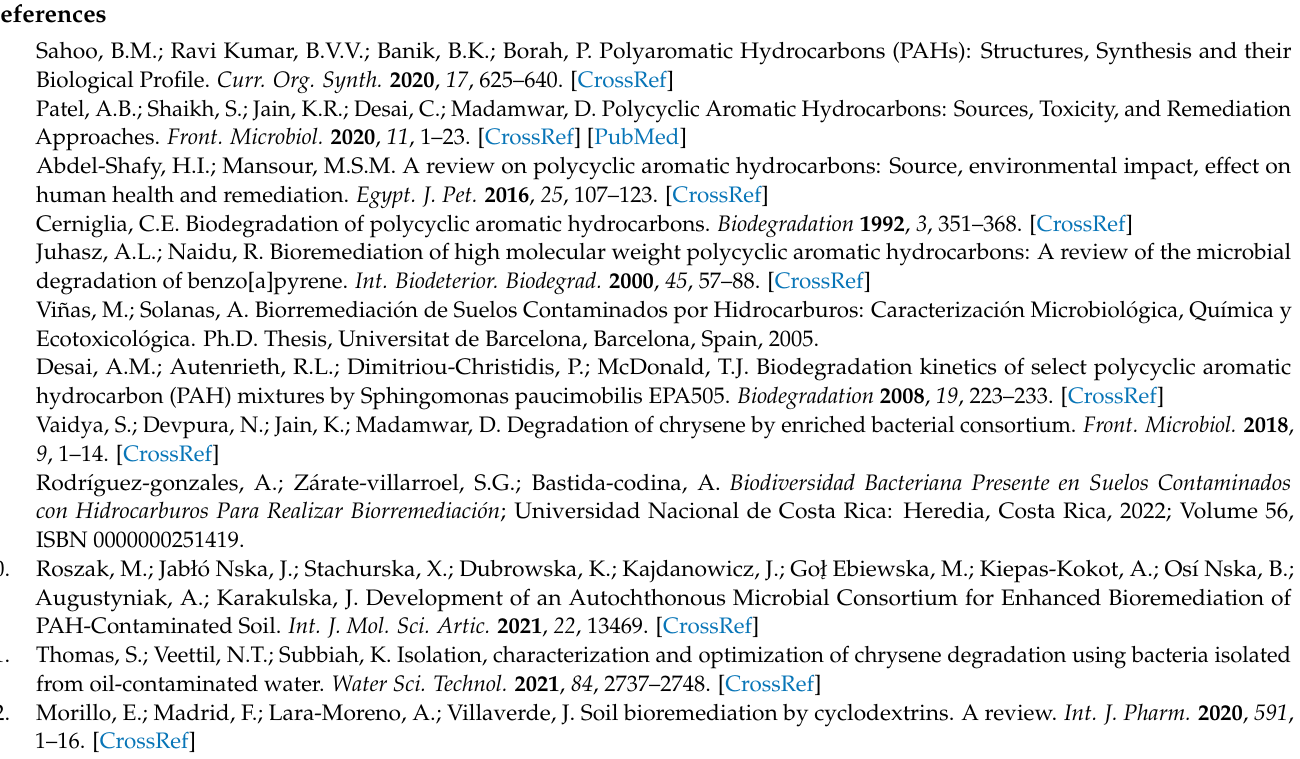
Table S2. Molecular surface area of dioxygenases and PAHs; Table S3. Docking scores of biodegraded PAHs by dioxygenases from different